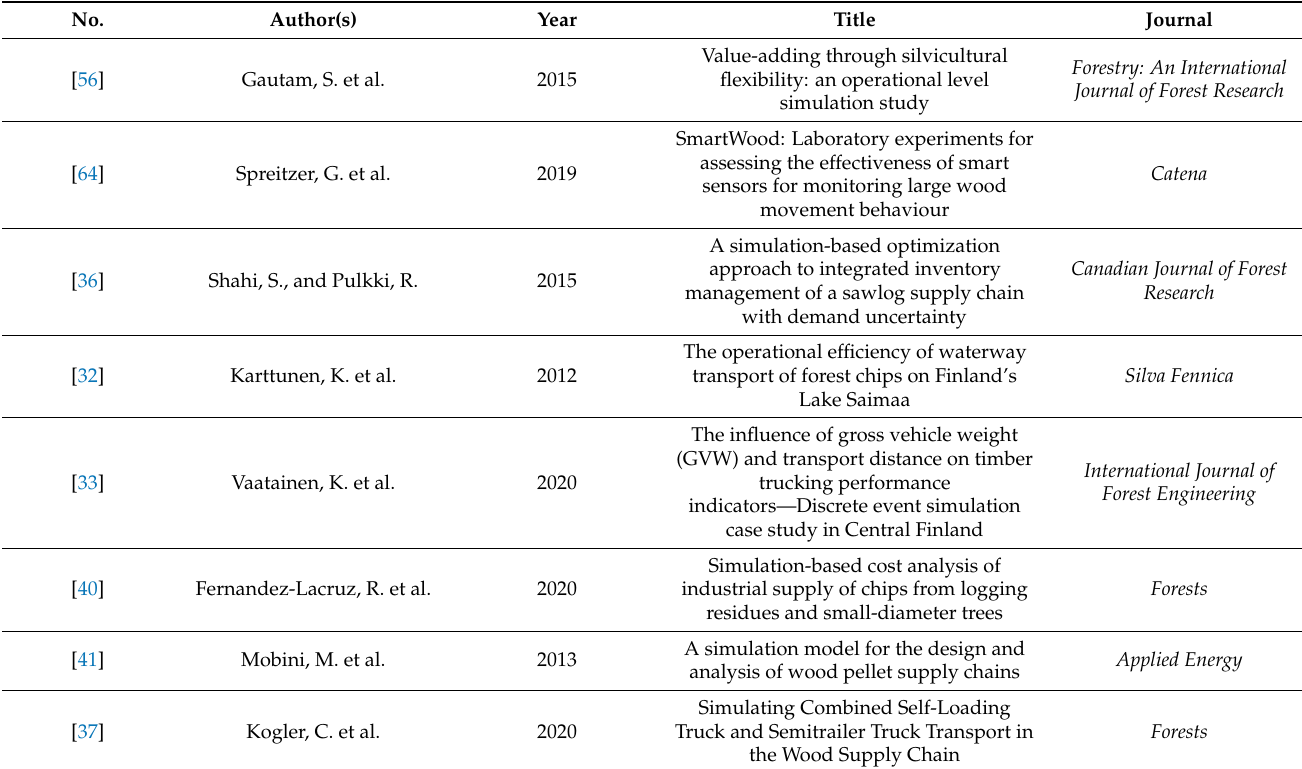
Table A1. List of included articles in the